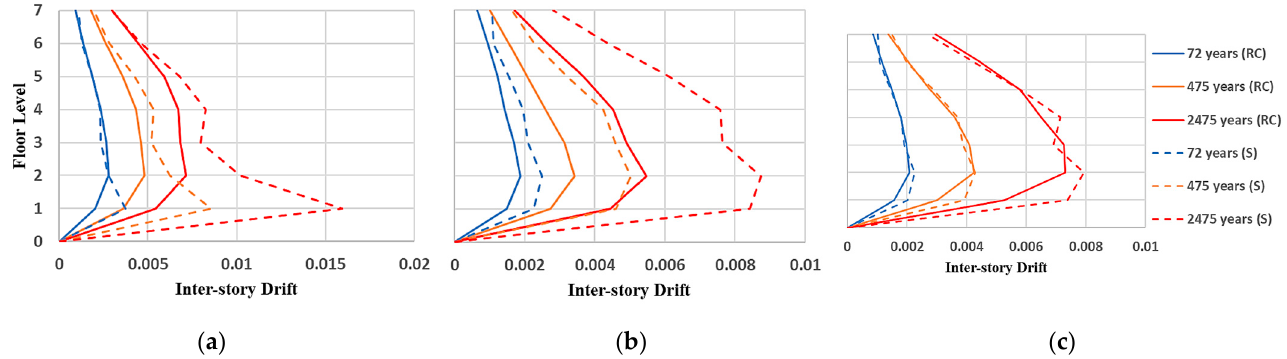
Figure 11. ( a ) Mexicali, Baja California, ( b ) Chilpancingo, Guerrero, ( c ) Oaxaca de Juarez, Oaxaca. Mean of the maximum inter-story drift response for each level of the steel and reinforced concrete structural model for seismic zone D.